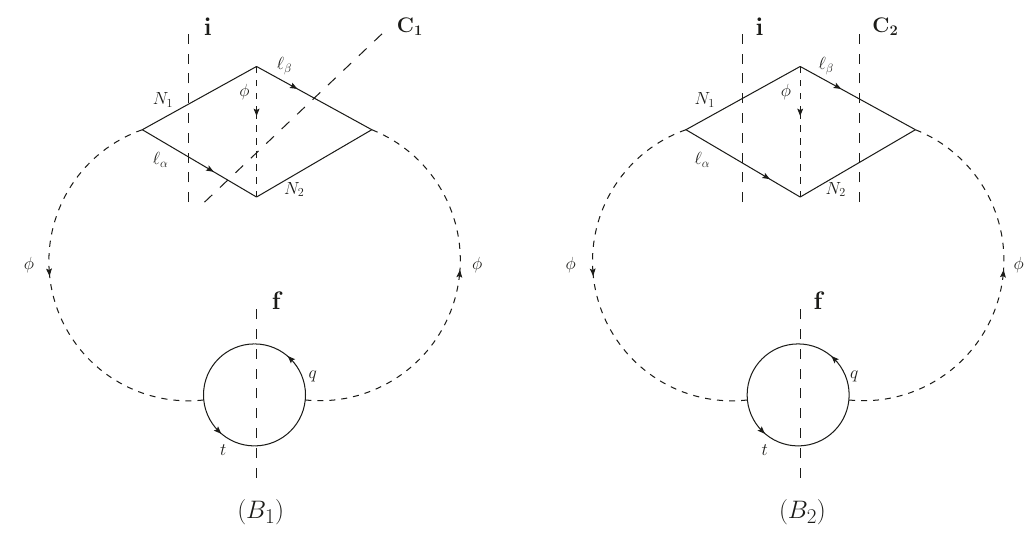
Figure 2 . Closed Feynman diagrams with three cuts, representing the interference of tree-level and one-loop amplitudes contributing to CP violation. The three cuts denoted by i , f , and C i determine the initial state, (cid:12)nal state, and Cutkosky cut, respectively. The graphs ( B 1) and ( B 2 ) correspond to the interference of the diagrams T a and L a cut along C 1 and C 2, respectively. Permuting the cuts f and C 1 ( C 2 ), yields the interference of the diagrams in the middle (bottom) of (cid:12)gure 1. divergences, as demanded by unitarity [24] (see also [35{37]). This point will be